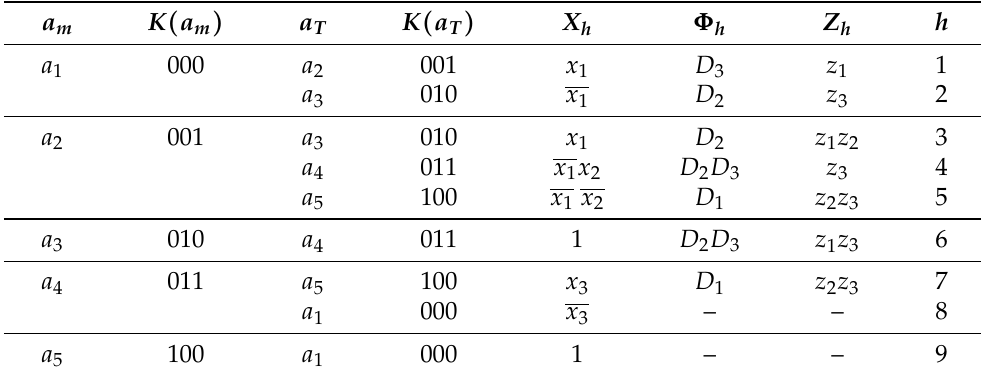
Table 3. Modified DST of Mealy FSM U 1 ( S 1 )